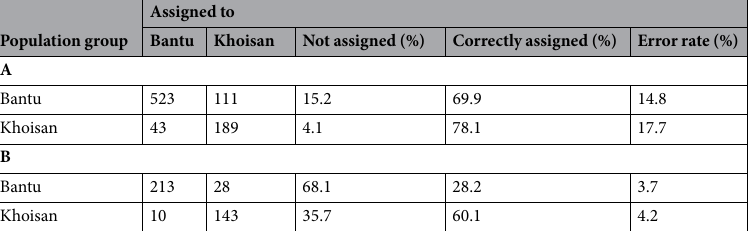
Table 2. Summary results of assignment of individuals to Bantu and Khoisan ethno-linguistic population groups with WHICHRUN (A) and STRUCTURE (B). The tables show the count of individuals assigned to each ethno-linguistic population group and the proportion of not assigned (admixed), correctly assigned, and wrongly assigned individuals.